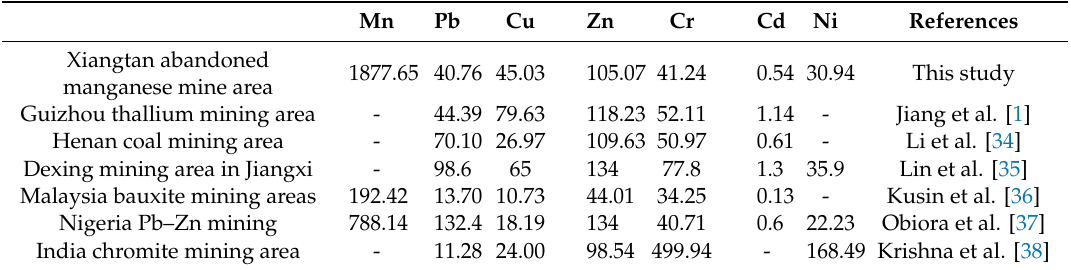
Table 2. Concentrations of soil PTEs (mg / kg) in abandoned manganese mines and other areas in Xiangtan.